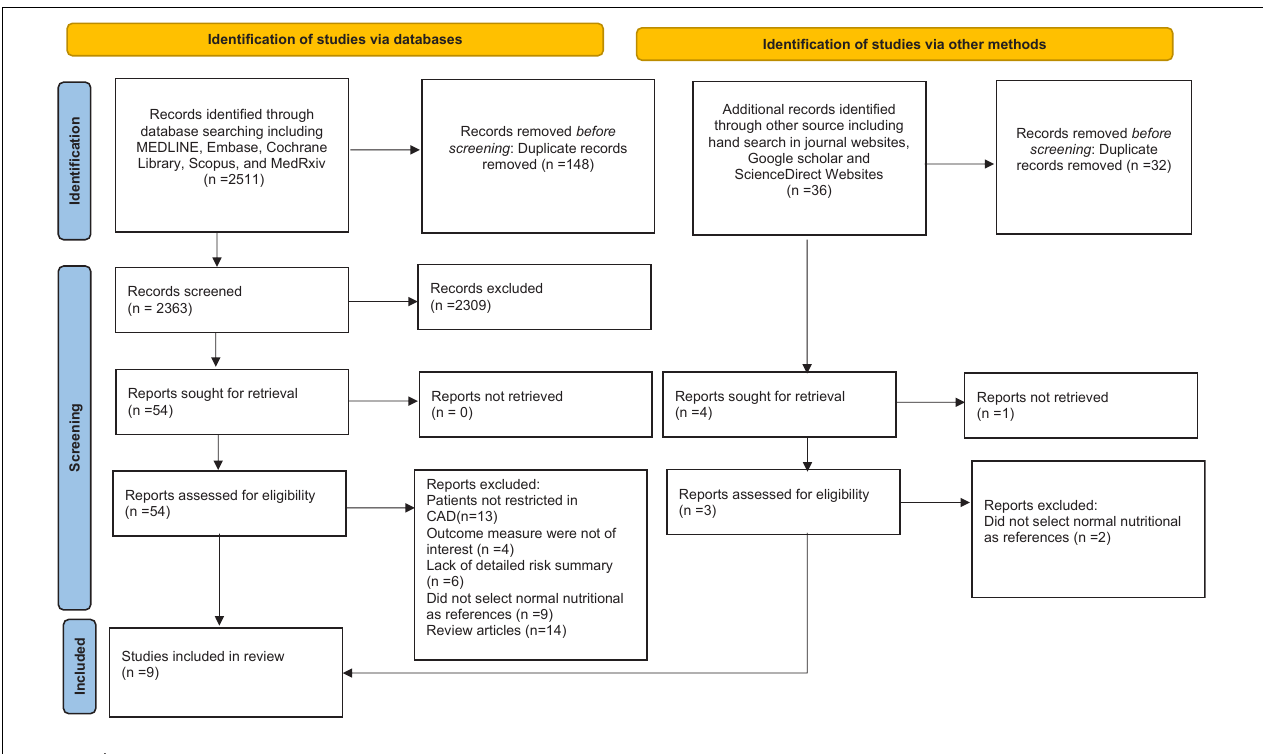
FIGURE 1 | Flow chart showing studies selection process.